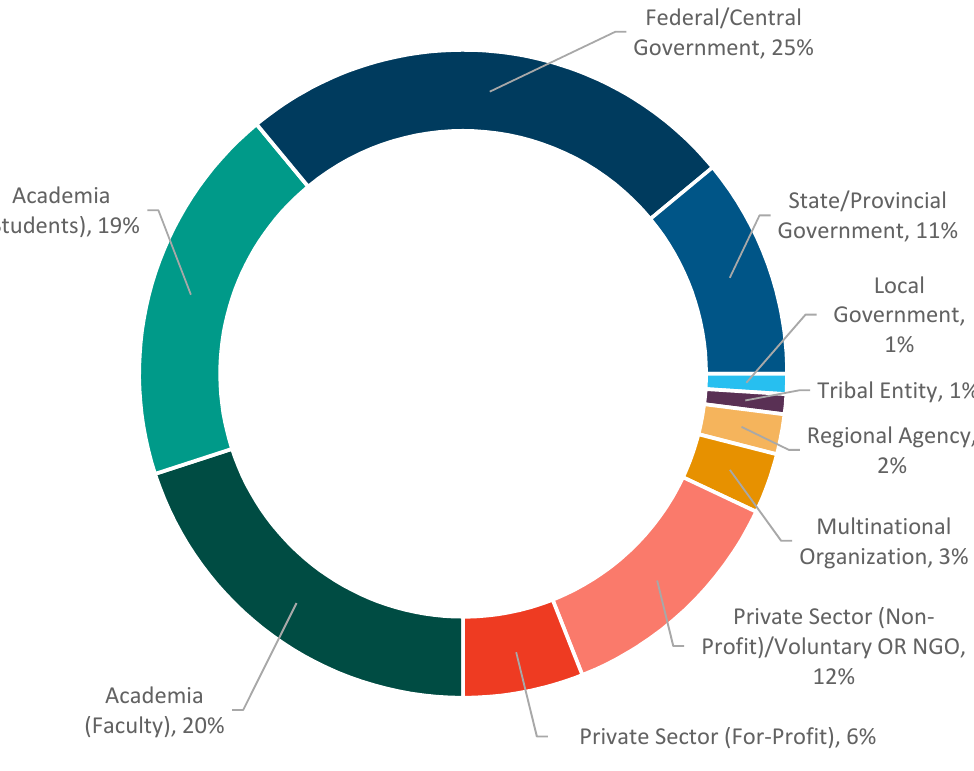
Figure1. Self-identifiedsectorsofAppliedRemote-SensingTraining(ARSET)trainingsurveyrespondents ( N = 1024). Figure 1. Self-identified sectors of Applied Remote-Sensing Training (ARSET) training survey respondents ( N = 1024).